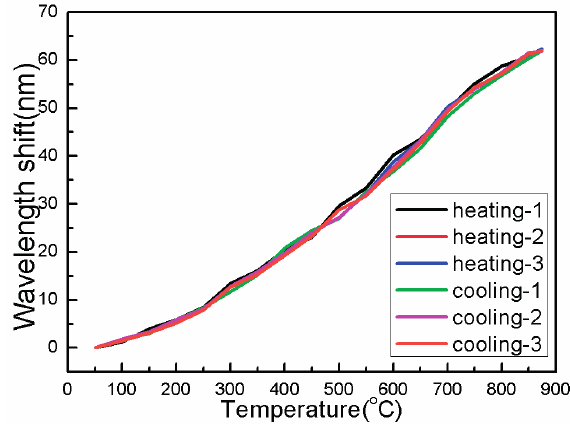
Figure 10. Cumulative wavelength responses of MZI sensor during heating and cooling processes from 25 °C to 875